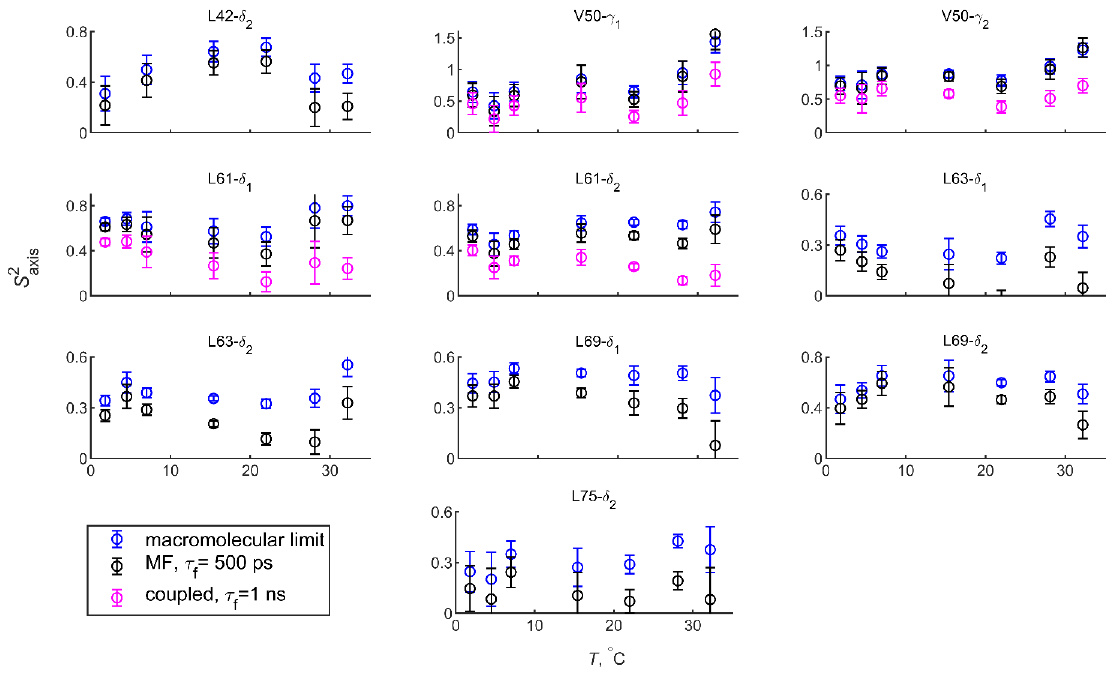
Figure 8. Methyl axis order parameters 𝑆 𝑎𝑥𝑖𝑠2 versus temperature for perdeuterated/LV protonated HP36 protein, obtained from the H i -H j /H i -C dipole-dipole cross-correlated relaxation rates and fitted according to three different approaches: using the macromolecular limit of Equation (5) (blue), using the model-free spectral density of Equation (4) with 𝜏 𝑓 fixed at 500 ps (black), and using the spectral density of Equation (6) allowing for coupling between the overall tumbling and internal motions and fixing 𝜏 𝑓 at 1 ns for V50 and L61 sites (magenta). Table 1. List of experimental η HH/CH rates obtained for HP36 perdeuterated/LV protonated protein in the absence of glycerol. The units are s −1 .